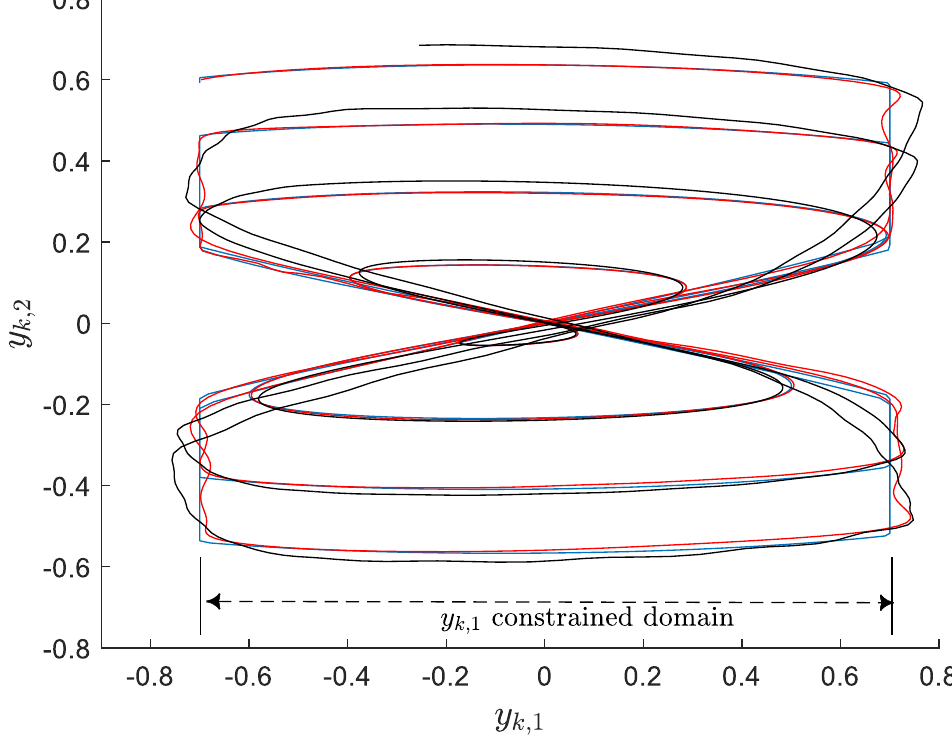
Figure 9. The recomposed tracking result on the long desired trajectory: y d y k ,2 (in red) obtained with optimal reference inputs ρ ∗ are with ρ k ,1 = y d